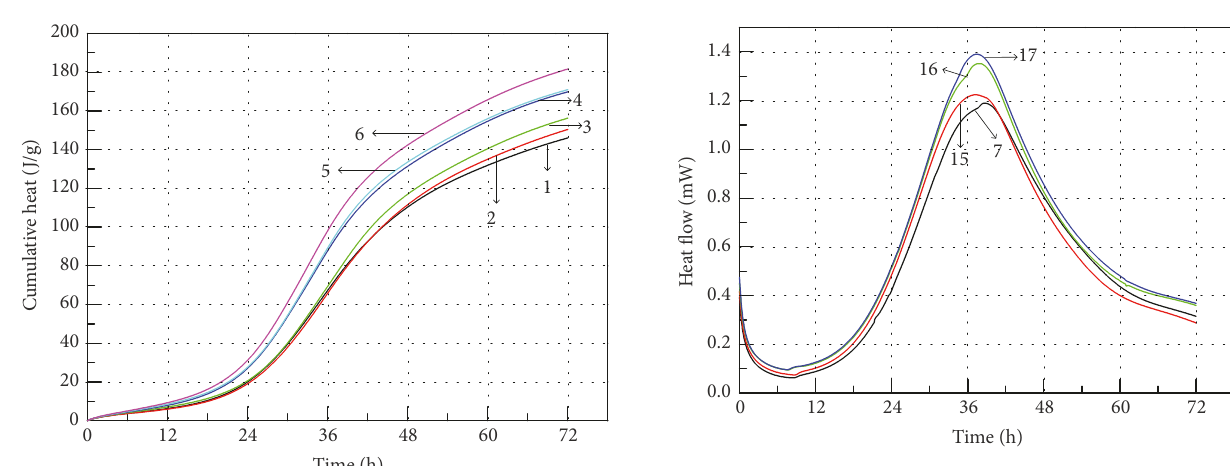
Figure 18: Heat flow versus time of references with SRA-SCA.